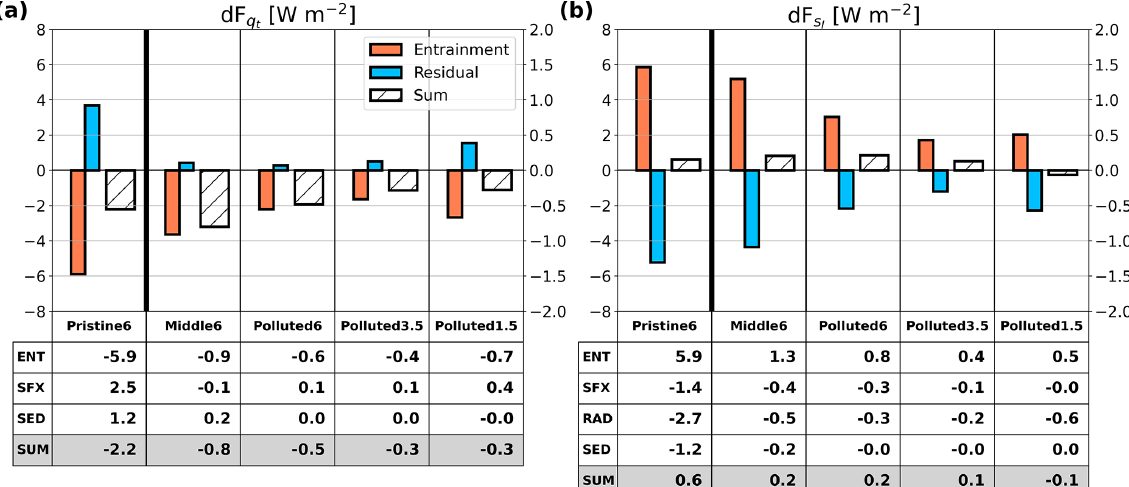
Figure 7. (a) Run-averaged differences between the Plume and Ctrl runs in q t flux into the boundary layer by entrainment (orange) and the sum of the surface flux and surface precipitation (residual, blue). The hatched bars represent the sum of all of the fluxes. Panel (b) is the same as panel (a) but for s l . Residuals here include the fluxes induced by radiation responses. The tables below the histograms show the mean values for entrainment (ENT), surface fluxes (SFX), and radiation (RAD; for s l only) as well as their sum (SUM). Note the logarithmic y -axis